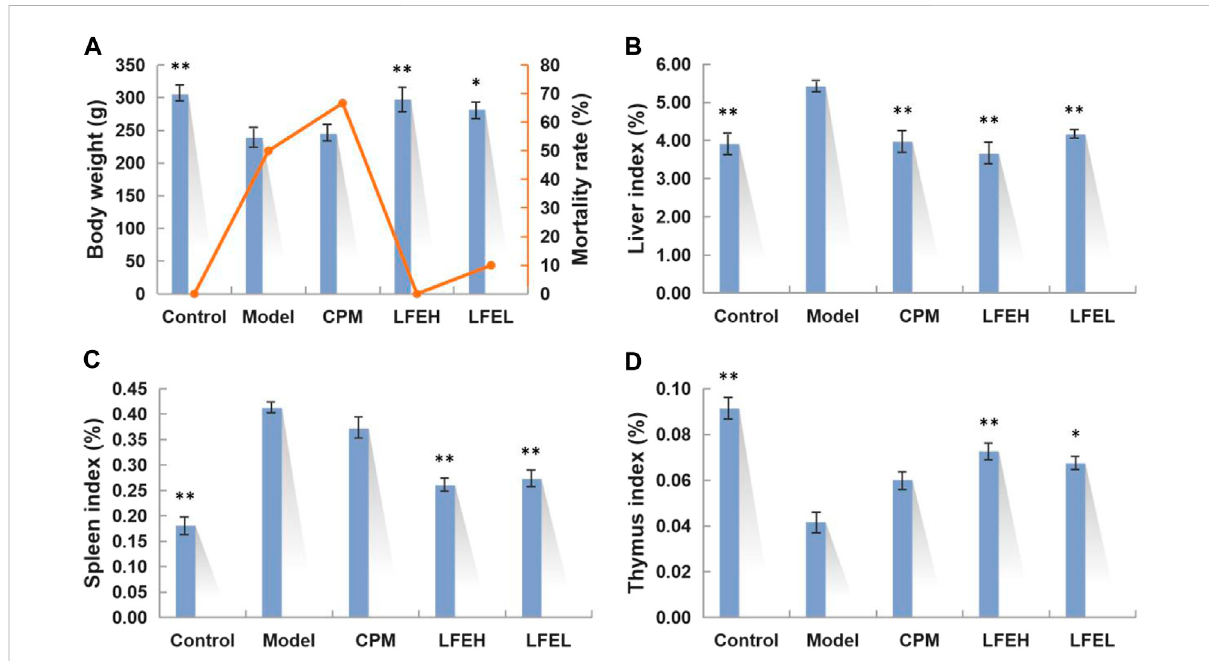
FIGURE 2 EffectsofLFEonphysiologicalindexesofHCCrats. (A) Bodyweightandmortalityrateofdifferentgroups. (B) Liverindexofdifferentgroups. (C) Spleen index of different groups. (D) Thymus index of different groups. The fi ndings were denoted to be mean ± SE. n = 8. * p < 0.05, ** p < 0.01 vs. model group. Control, the blank group; Model, the model group; CPM, the cyclophosphamide group; LFEH, LFE high-dose group; LFEL, LFE low- dose group.